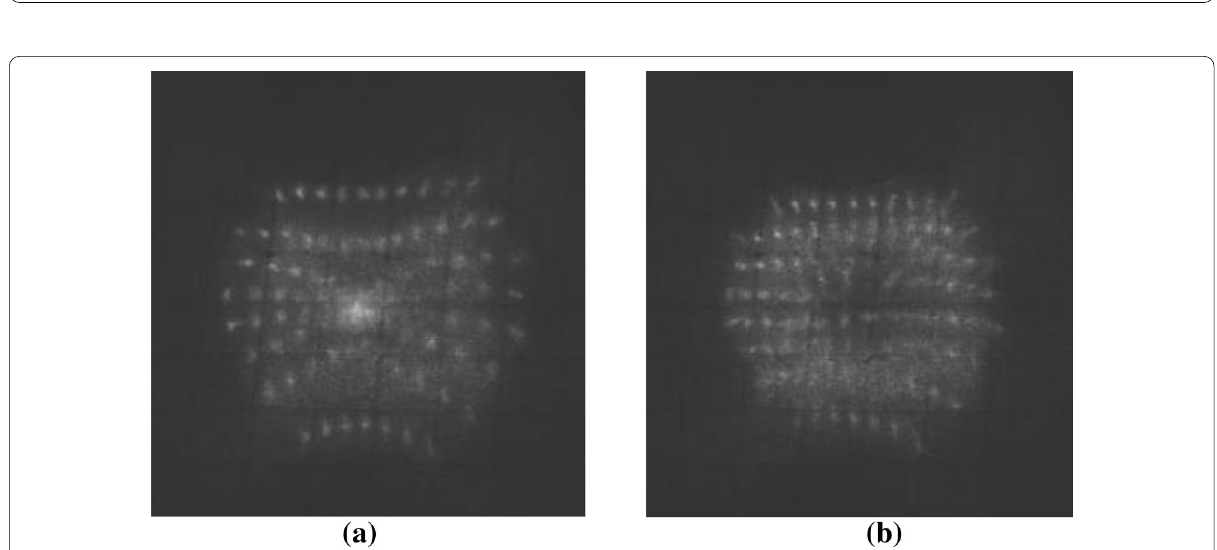
Figure 13 Experimental results of (0, 2)